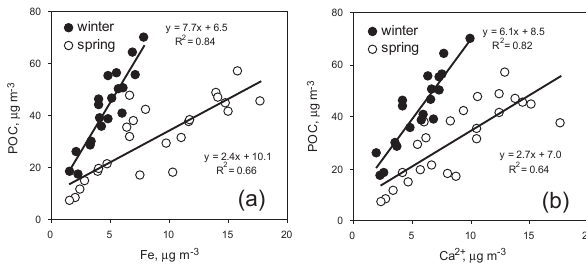
Fig. 6. Correlation of primary organic carbon (POC) with Fe and Ca 2 + in the PM 10 of Baoji City. Fig. 6 Correlation of primary organic carbon (POC) with Fe and Ca 2+